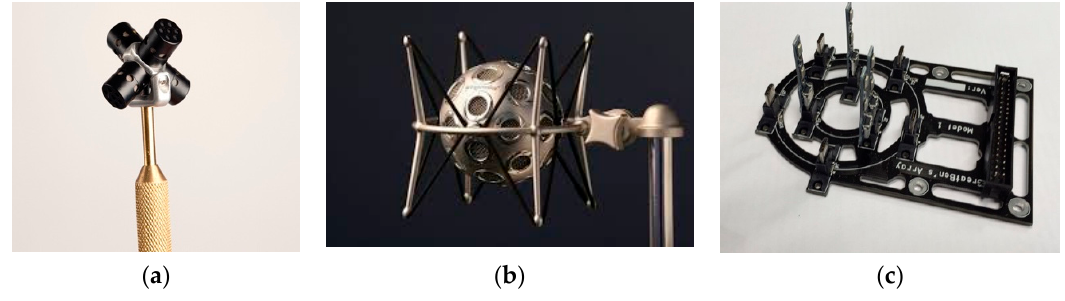
Figure 3. 3D soundfield recording microphones. ( a ) TetraMic; ( b ) EigenMike; ( c ) Planar Microphone